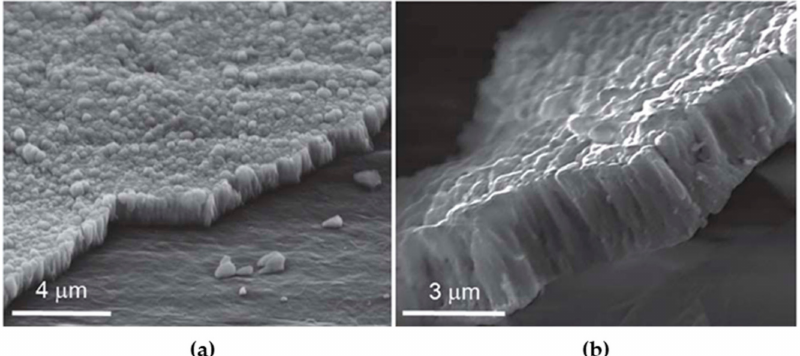
Figure 3. Scanning electron microscope (SEM) images of yttria-stabilized zirconia (YSZ) coatings deposited on ultra-high molecular weight polyethylene (UHMWPE): ( a ) microphotograph of a ≈ 1.7 µ m thick coating; ( b ) detail of the cross-section of a ≈ 3 µ m thick coating, reproduced from [15] with permission from the Royal Society of